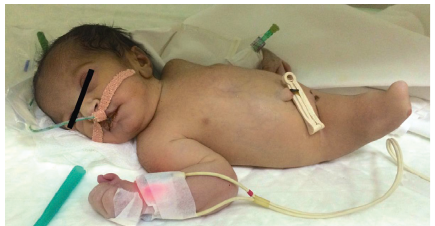
Figure 1: Sirenomelic baby showing no genitalia.